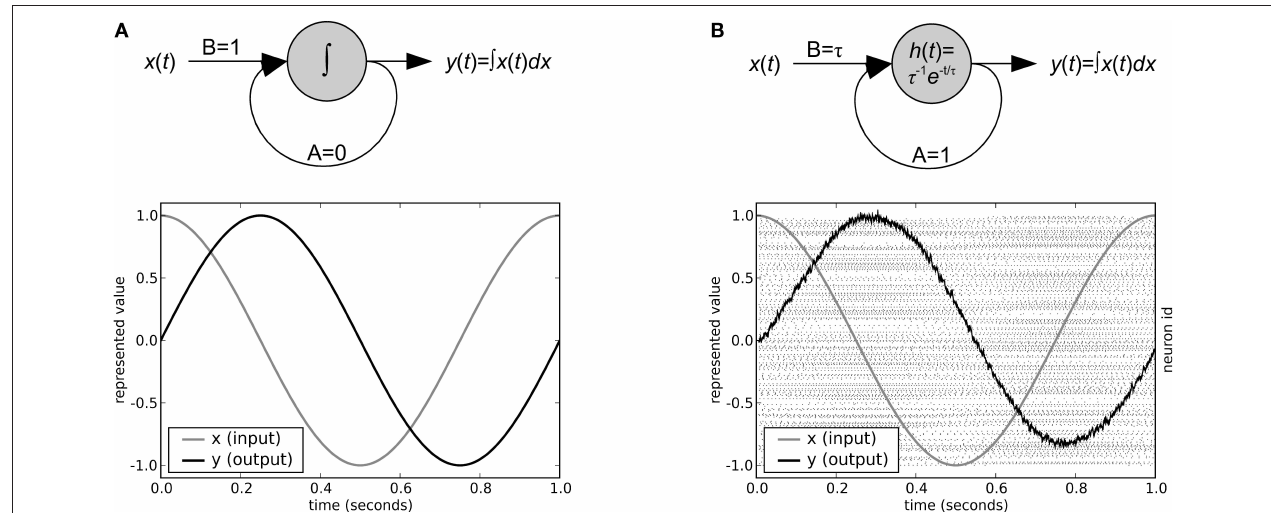
FIGURE 3 | A classic control-theory integrator (A) and an NEF integrator (B). Both integrators are provided with the same sine wave input x ( t ). The NEF integrator uses 300 LIF neurons with maximum fi ring rates distributed uniformly between 100 and 200 Hz, post-synaptic current time constants of